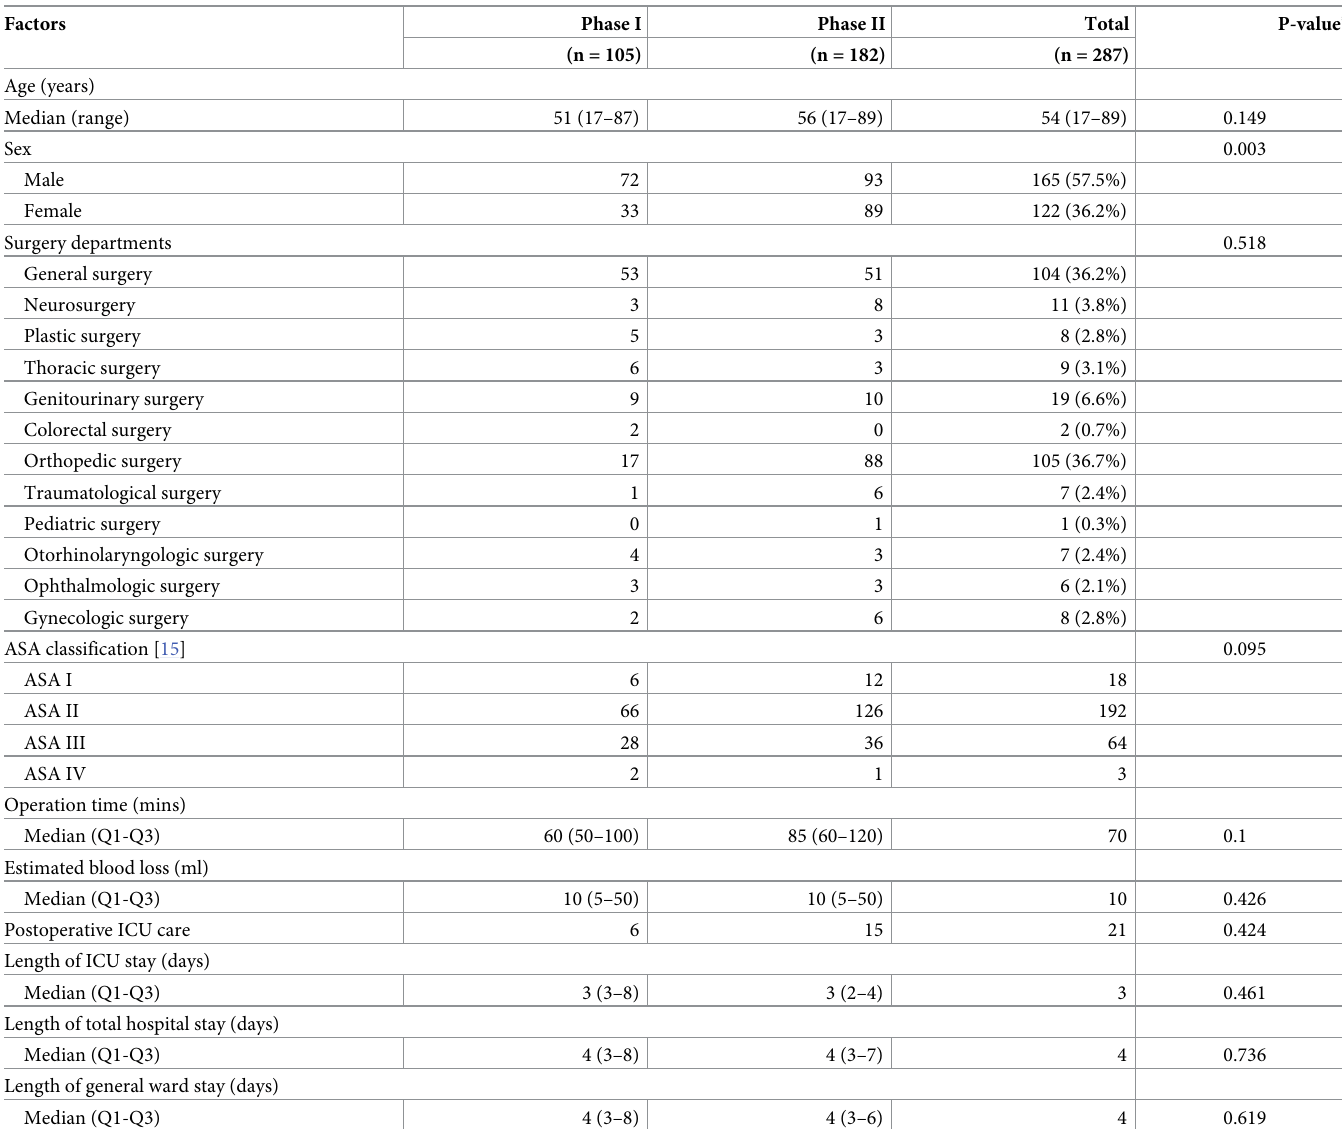
Table 1. Basic characteristics of the patients.